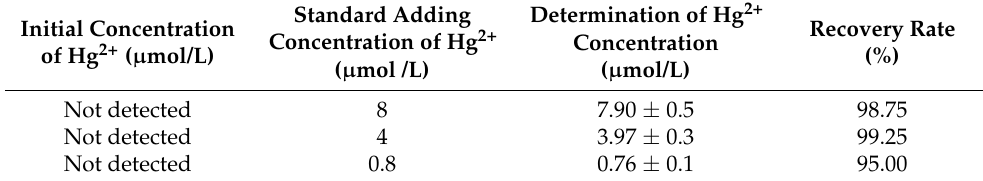
Table 1. Recovery test of Hg 2+ in water samples.